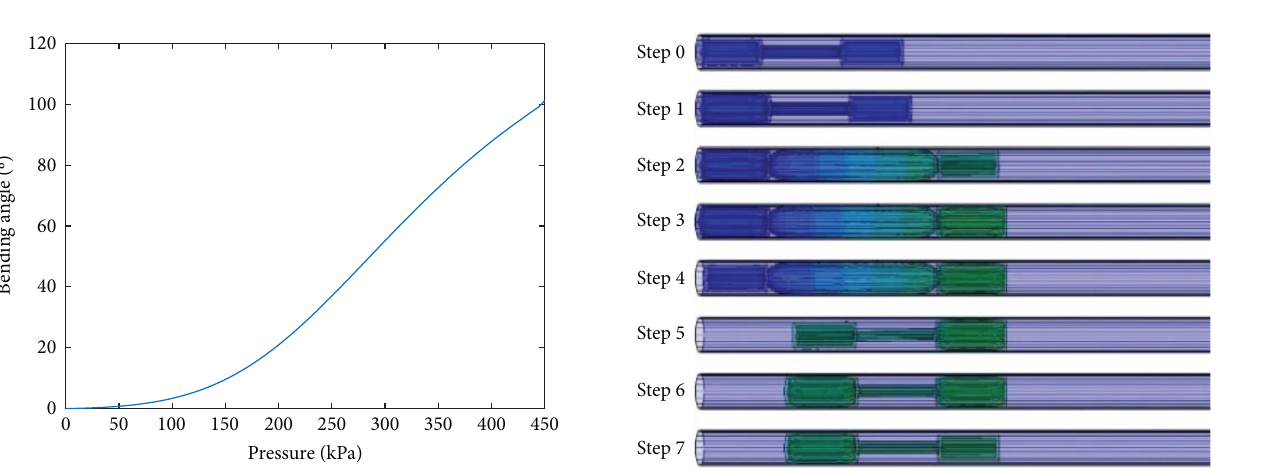
F IGURE 8: Simulation curves of the deformation part.